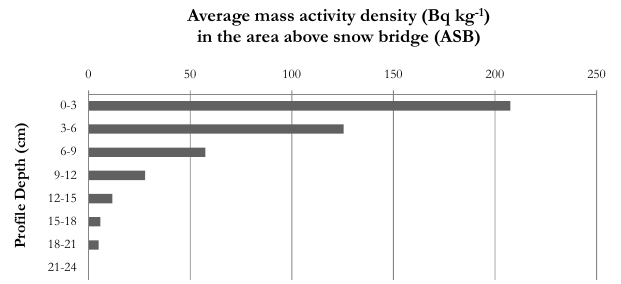
Fig. 6. Soil deposition rates in the area Above the Snow Bridges (ASB), in the Upper Deposition Area (UDA) and in the Lower De- position Area